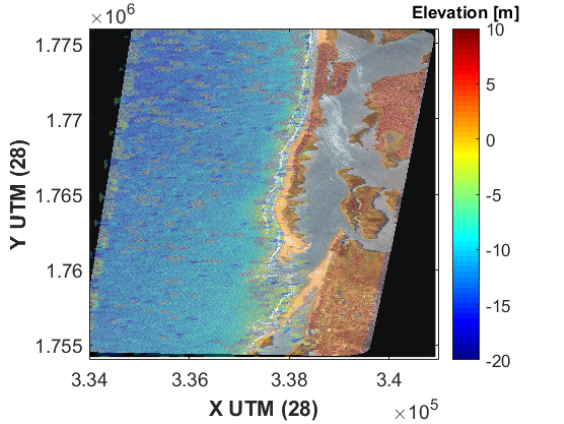
Figure 4. Spatial land/sea continuum derived from Pleiades 03/2020 acquisition, the vertical height (in meter) is represented with the color